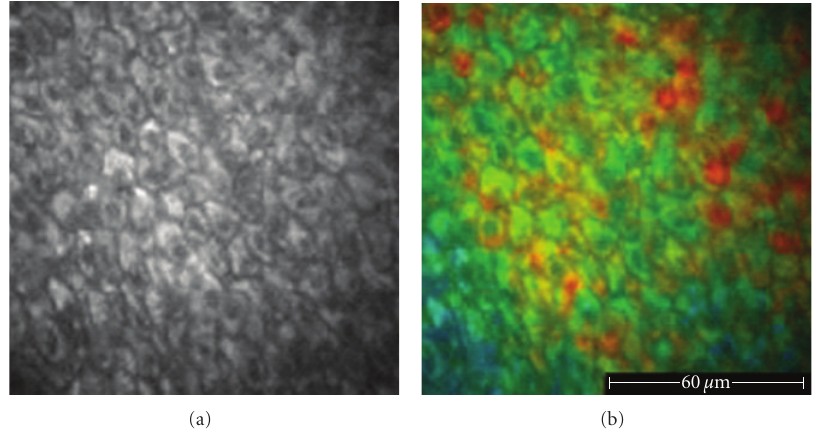
Figure 4: In vivo healthy skin, 760nm excitation wavelength. The acquisition of the images has been achieved by means of the DermaInspect equipped with the FLIM system, planned, and built by the Photonics Group of the Imperial College of London. (a) The autofluorescent signals of keratinocytes, melanin containing keratinocytes, and melanocytes appear monomorphous, and, in the grey-scale images, they cannot be distinguished from each other. (b) The FLIM image enables the identification of melanin-containing cells based on the di ff erent fluorescence decay time values (keratinocytes appear green-blue and melanin containing keratinocytes and melanocytes appear yellow-red).